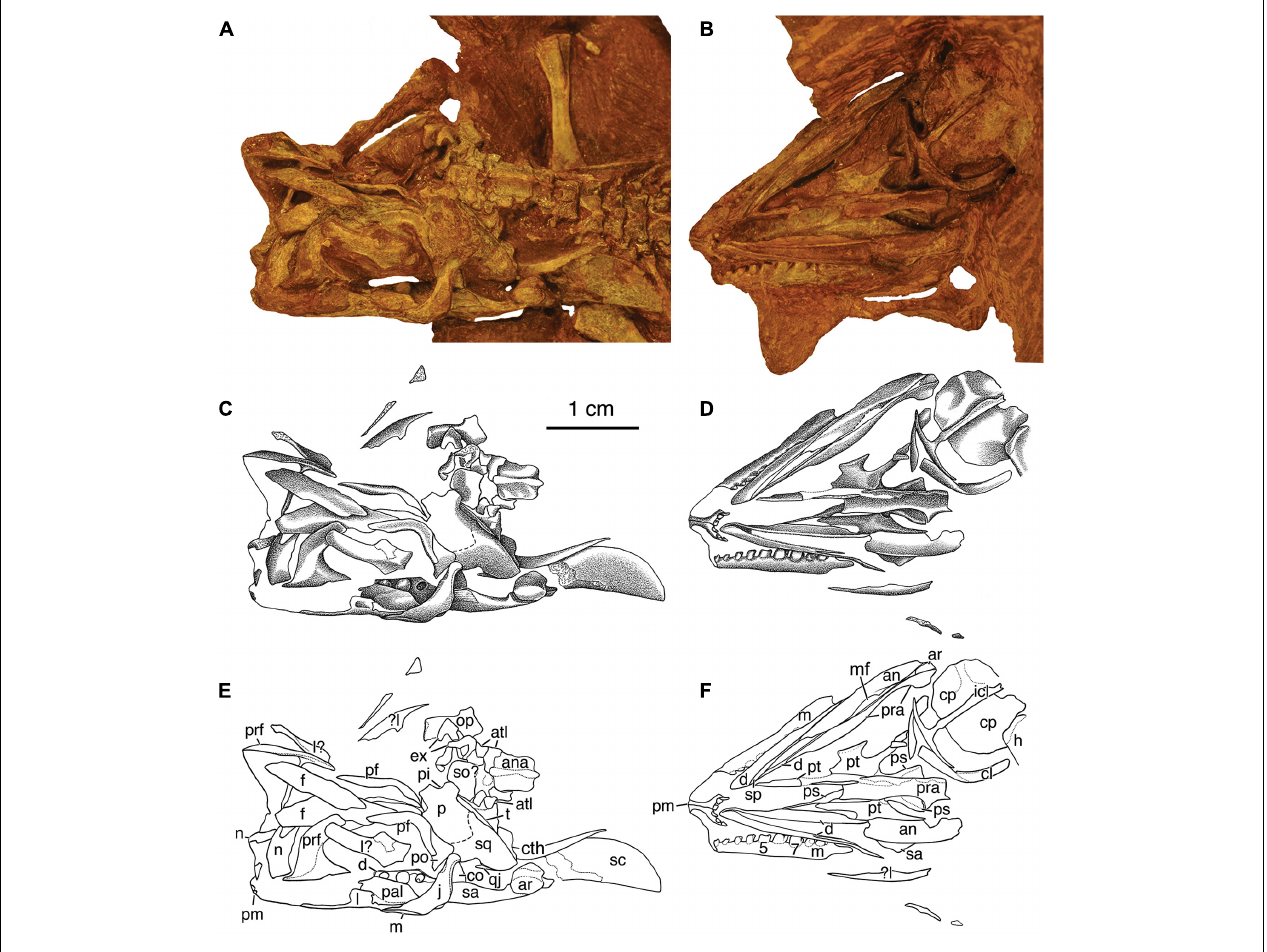
FIGURE 3 | Skull of Eudibamus cursoris , holotype (MNG 8852). (A,B) Photographs, (C,D) illustrations, and (E,F) labeled outline drawings of elements of dorsoventrally crushed skull in (A,C,E) , dorsal and (B,D,F) , ventral views. Dorsal views of skull (A,C,E) also include disarticulated elements of the braincase and atlas-axis complex, dorsal portion of laterally exposed left scapula and cleithrum, and right humerus. Ventral views of skull (B,D,F) also include disarticulated elements of the dorsal portions of laterally exposed left scapula and cleithrum and partially exposed ventral view of shoulder girdle. Abbreviations in this and following figures as listed in